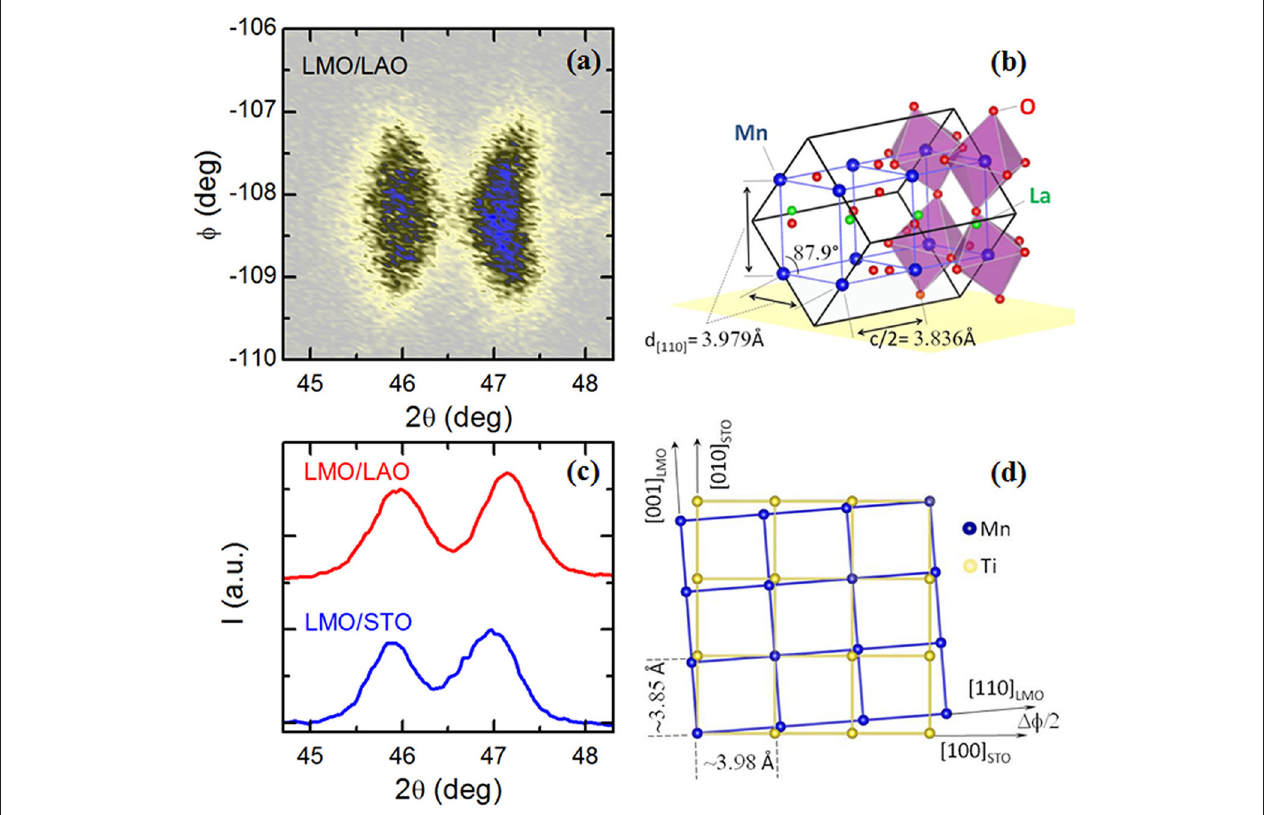
FIGURE 3 | (A) In-plane 2 θ – φ area scan of (200) reflection of LMO sample grown on LAO (right) substrates. (B) Schematic representation of the (110) epitaxial growth of orthorhombic LMO thin films on cubic perovskite substrates. (C) Phi-integrated intensity of 2 θ – φ area scan for LMO/STO (blue) and LMO/LAO (red). (D) Schema of the in-plane accommodation of LMO films onto STO substrates showing the matching along [110] STO